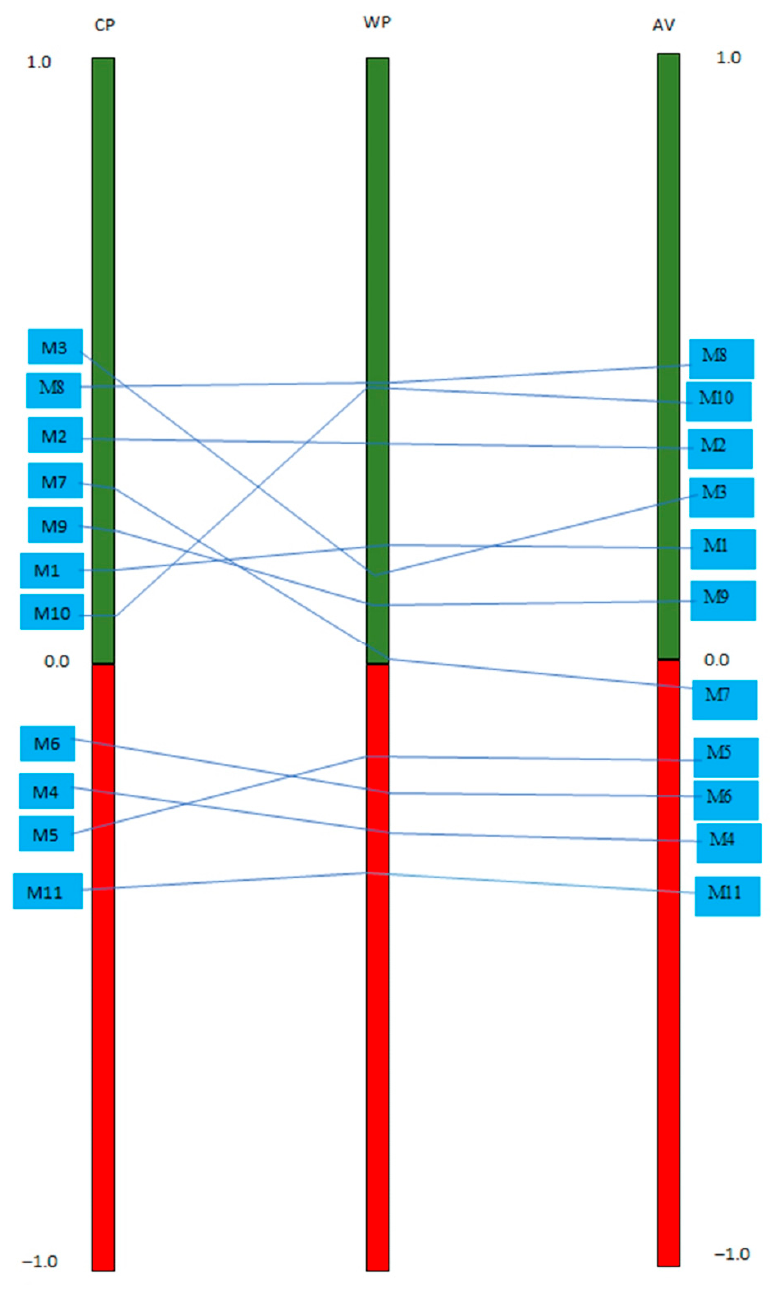
Figure 4. Comparison of all three scenarios.